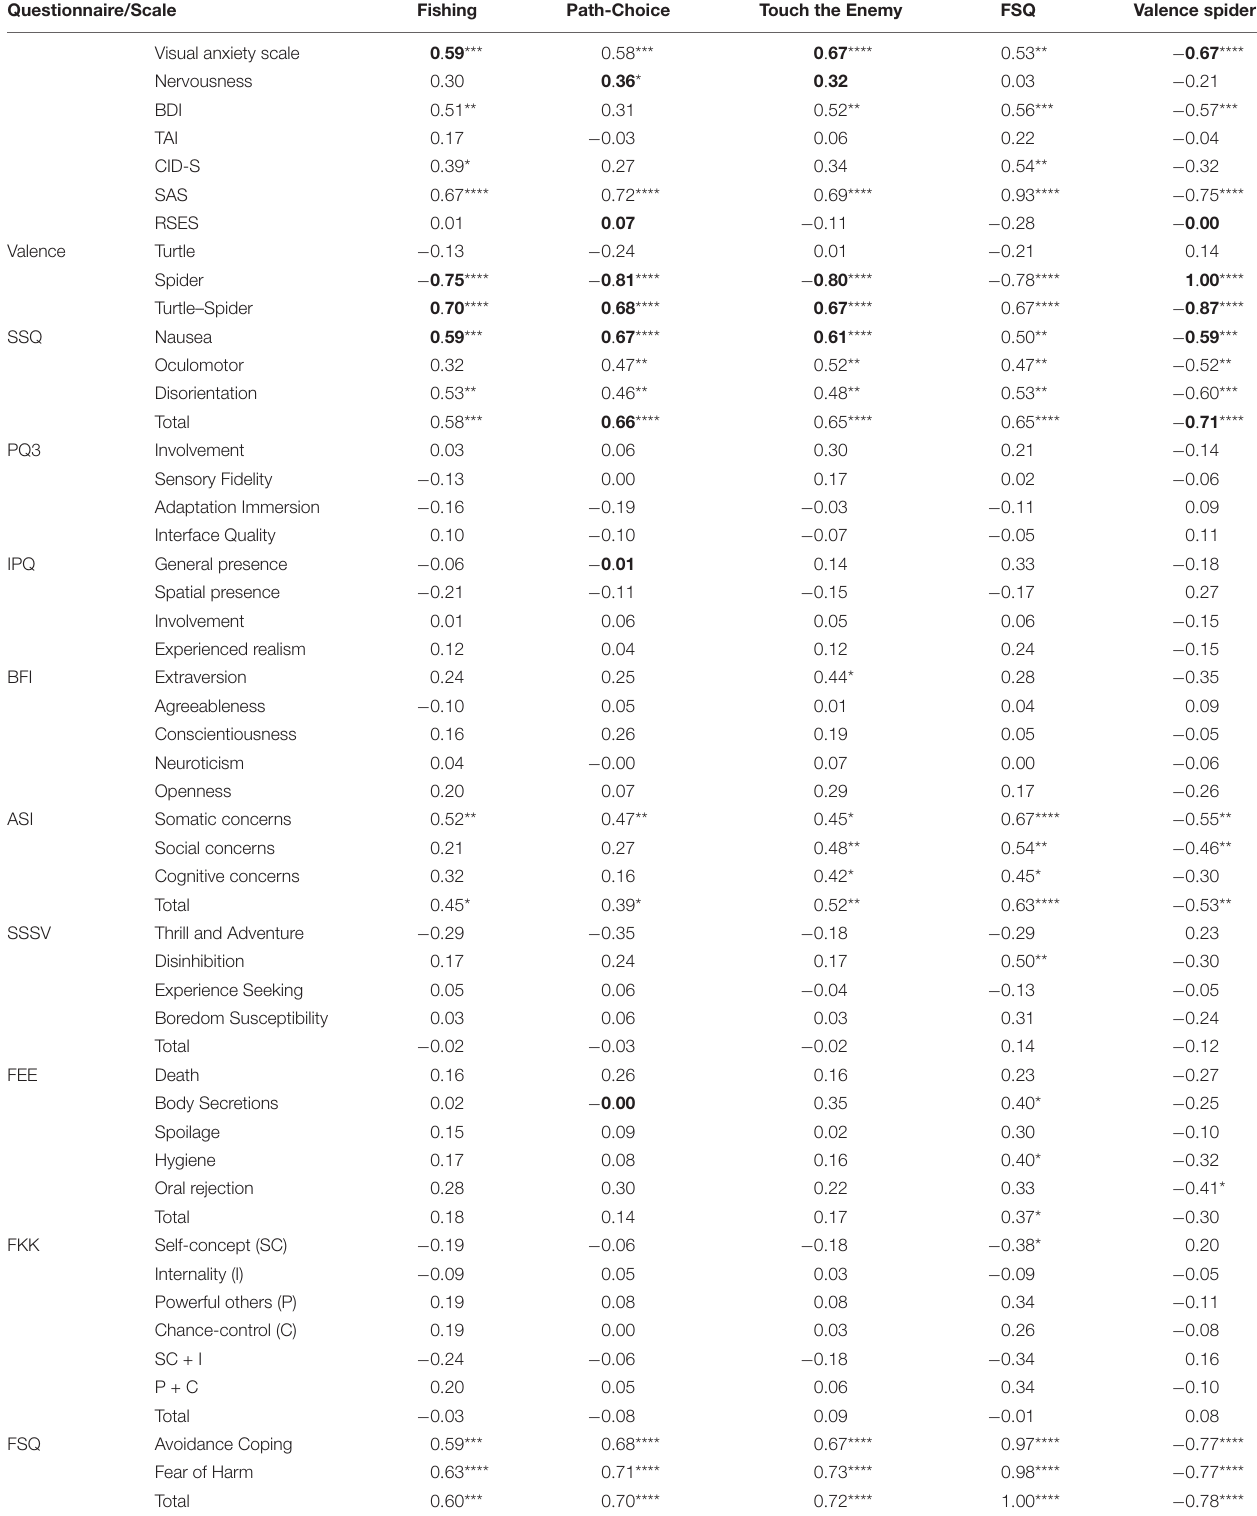
TABLE 1 | Spearman correlations between questionnaires and behavioral tasks. Questionnaire/Scale Fishing Path-Choice Touch the Enemy FSQ Valence spider Visual anxiety